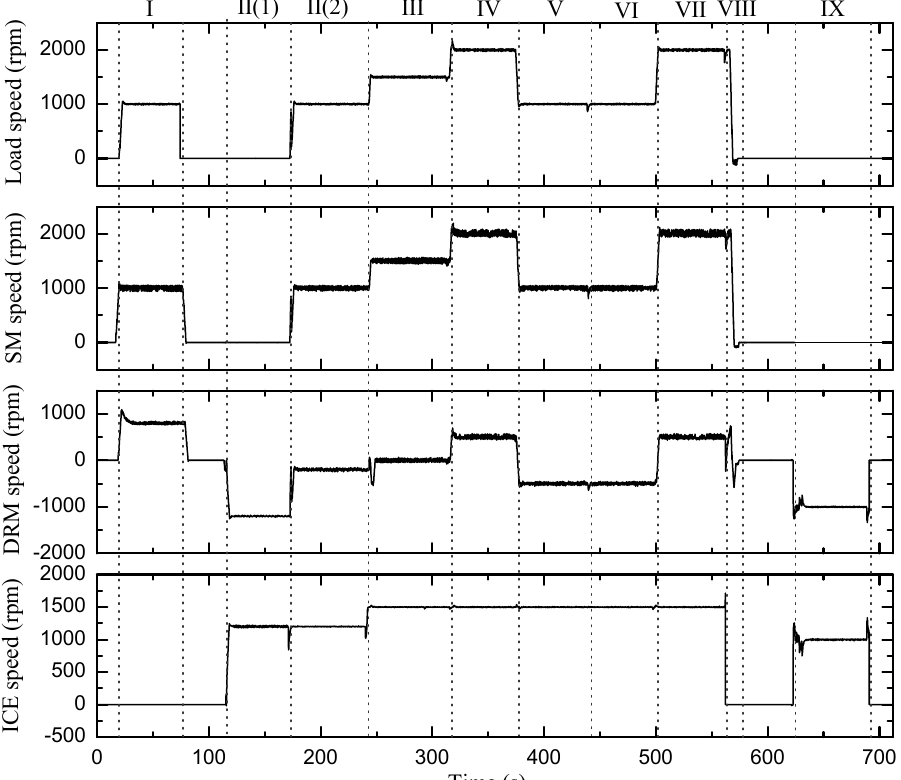
Figure 9. The tested speed curves of the ICE, DRM, SM and load